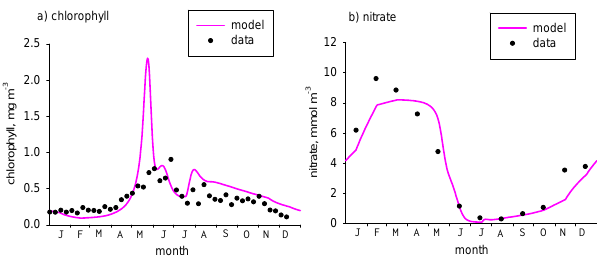
Figure 10. Simulation for station BIOTRANS using first-guess pa- rameters compared to data (year 2002) for (a) chlorophyll and (b)